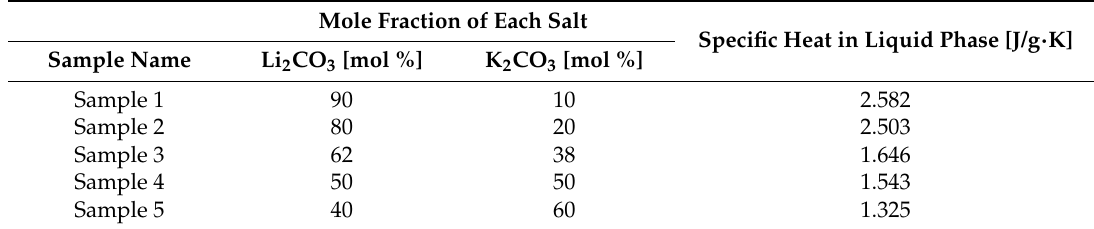
Table 1. Chemical compositions and specific heat of carbonate salt mixtures for Group 1 samples. Mole Fraction of Each